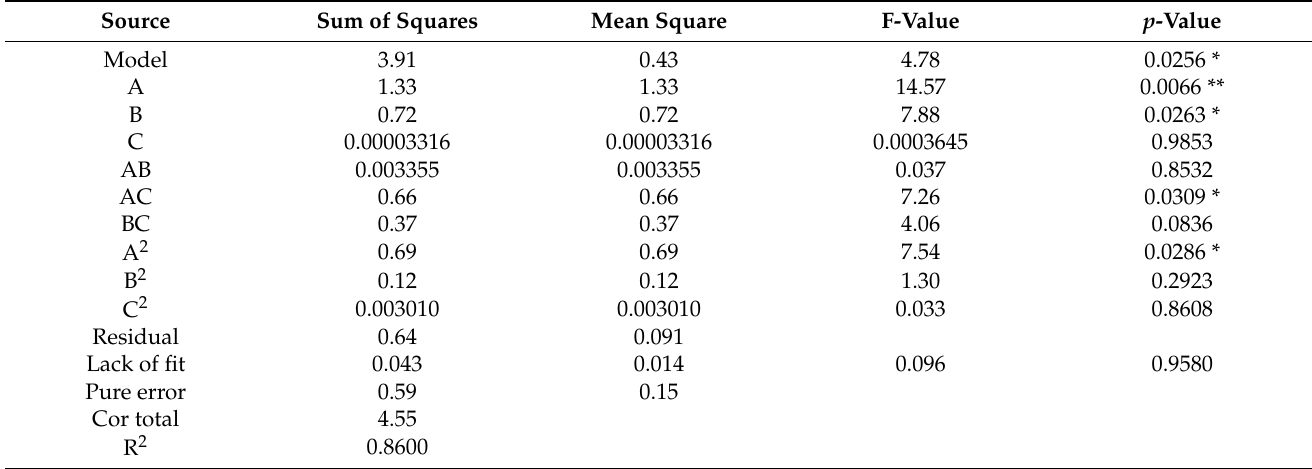
Table 4. Regression model statistical